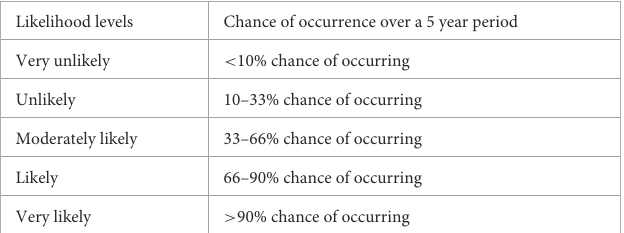
TABLE 2 UK Non-native Organism Risk Assessment scheme likelihood descriptors for entry and establishment (44). Likelihood